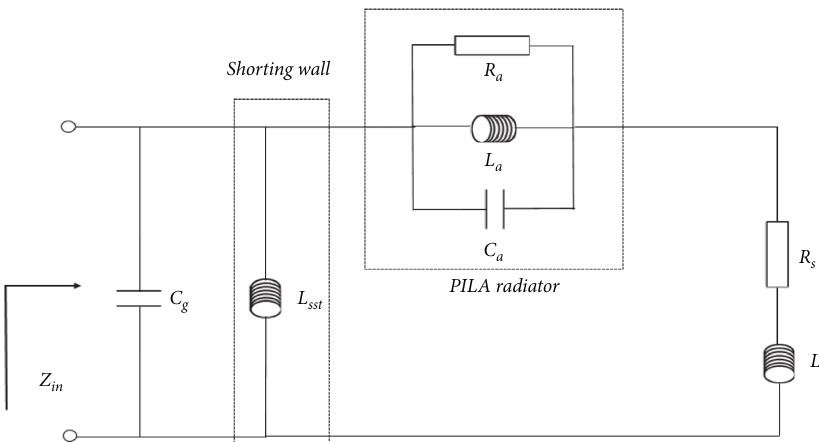
� 1380 Ω , L � 5.25nH, C � 5.9pF, R � 0.045 Ω , L � 14.84nH, a a a s s